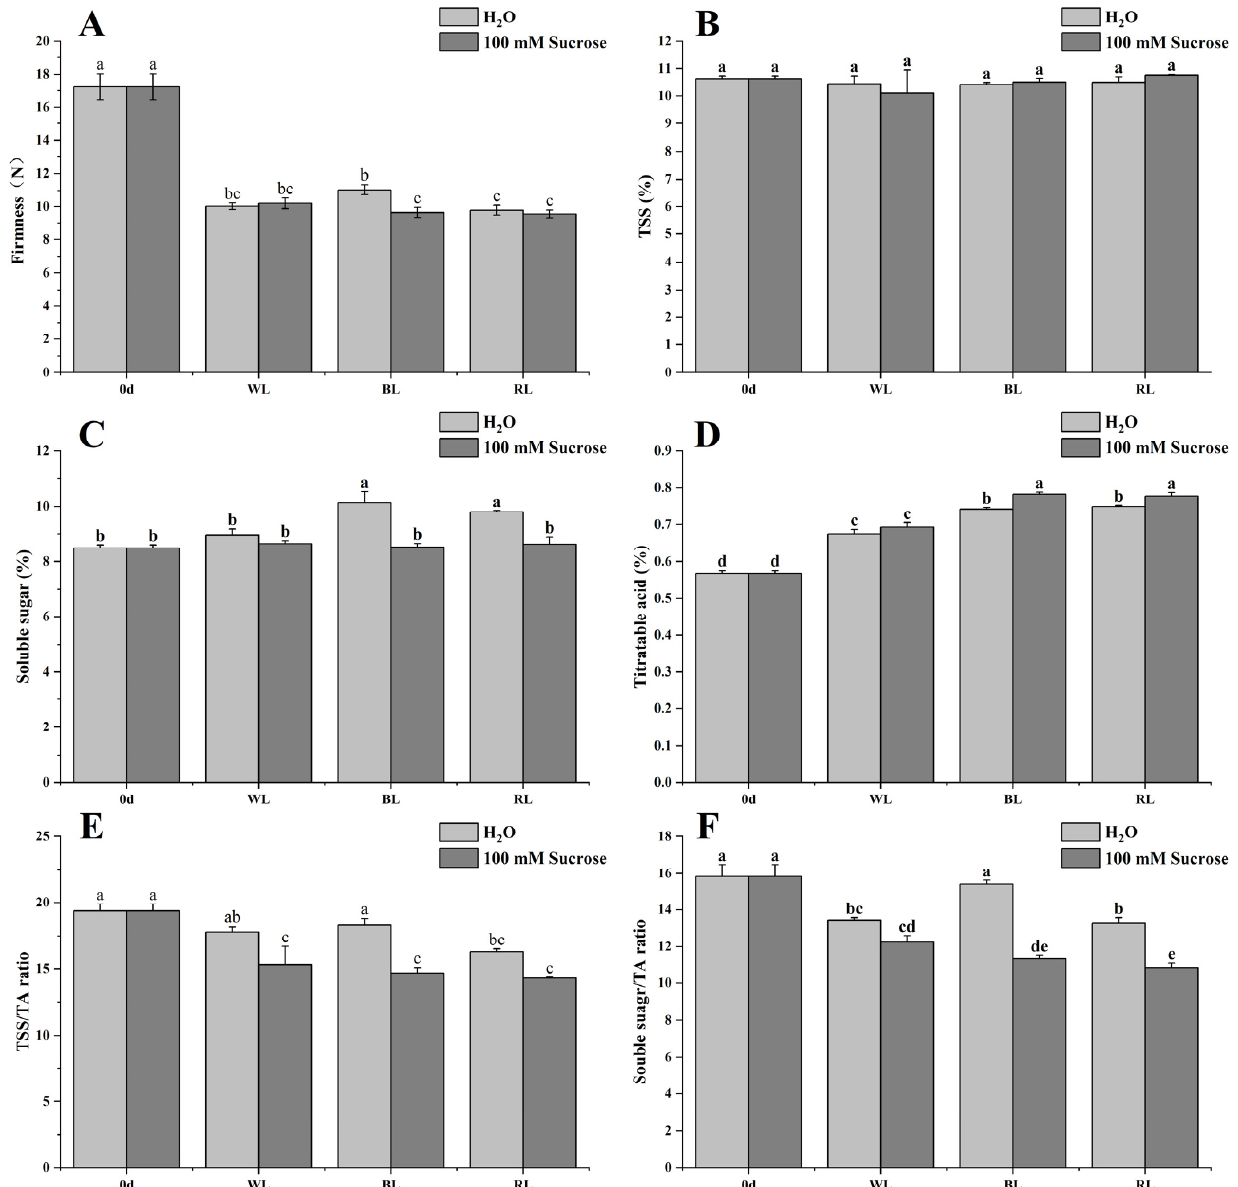
Figure 2. Effect of light quality and sucrose on firmness ( A ), TSS ( B ), soluble sugar ( C ), Titratable acid ( D ), TSS/TA ratio ( E ), and soluble sugar/TA ratio ( F ). Data represent the means ± standard error ( n = 3). Different lowercase letters indicate the statistically significant difference of the mean values based on one-way analysis of variance (ANOVA) followed by Duncan’s multiple range test ( p ≤ 0.05).